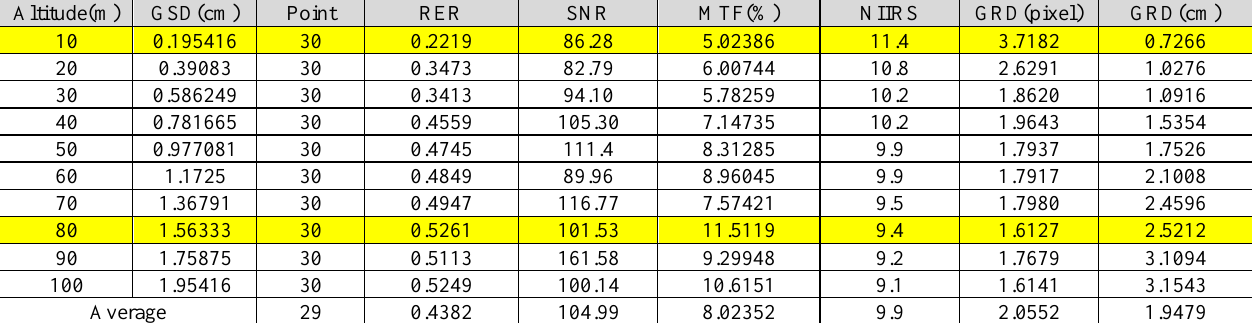
Table 6. Image quality parameters in the Third drone shot images